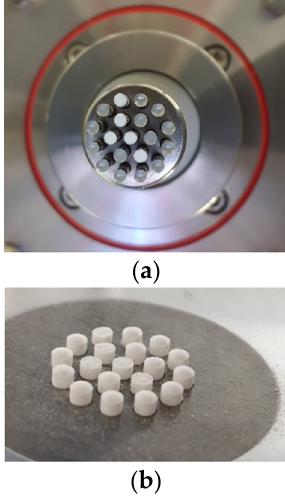
Figure 2. ( a ) Sticking on punches (upper punch displayed), leading to ( b ) damaged mini-tablets of F 6 with SMCC 50 and 3%